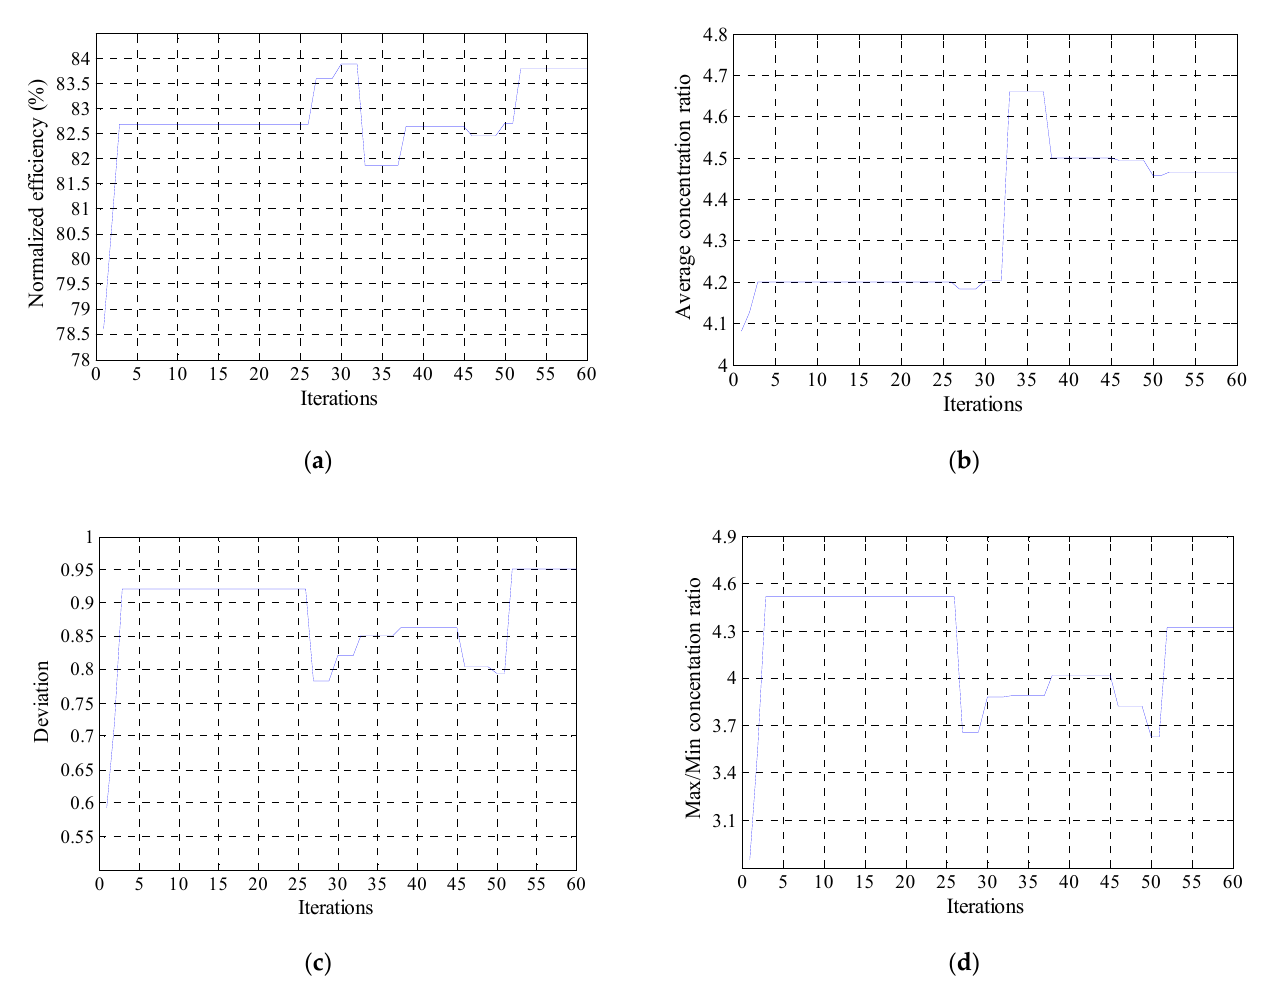
Figure 7. Variation of optical parameters with iterations: ( a ) normalized collection efficiency; ( b ) average concentration ratio; ( c ) concentration ratio deviation; ( d ) ratio between the maximum and the minimum.